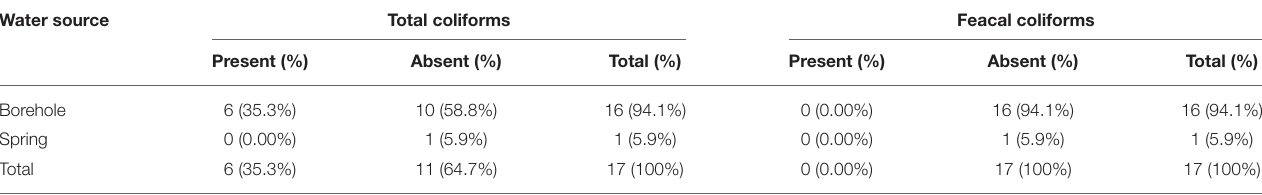
TABLE 2 | Bacteriological quality of packaged water in Lusaka. Water source